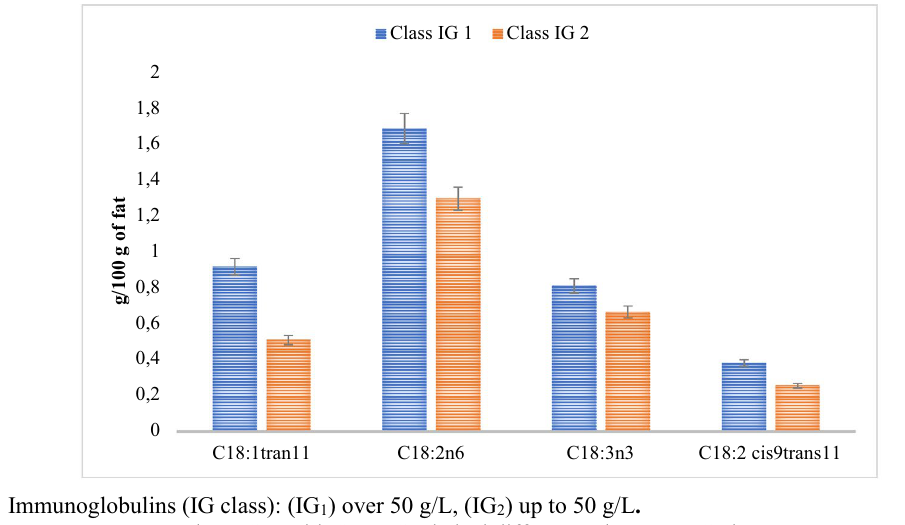
Figure 3. Changes in selected fatty acids’ content for different IG concentrations.